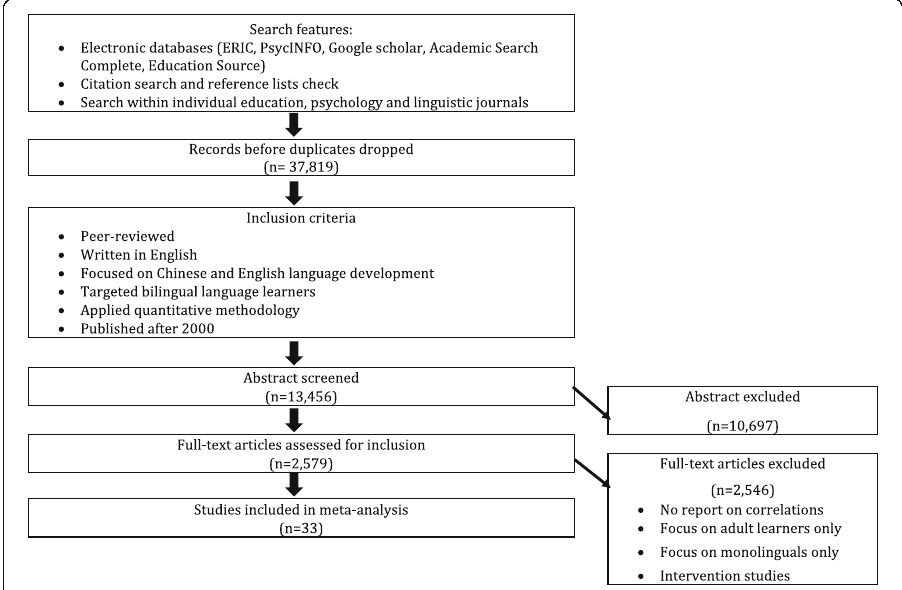
Fig. 1 Flow chart for the literature search and inclusion of studies (adapted from Melby-Lervag & Lervag,